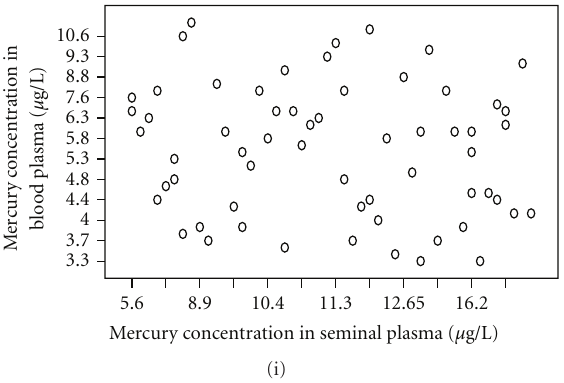
Figure 1: (a) Relation between lead concentrations in seminal plasma and blood plasma. (b) Relation between lead concentrations in seminal plasma and whole blood. (c) Relation between lead concentrations in blood plasma and whole blood. (d) Relation between cadmium concentrations in seminal plasma and blood plasma. (e) Relation between cadmium concentrations in seminal plasma and whole blood. (f) Relation between cadmium concentrations in blood plasma and whole blood. (g) Relation between mercury concentrations in blood plasma and whole blood. (h) Relation between mercury concentrations in seminal plasma and whole blood. (i) Relation between mercury concentrations in blood plasma and whole blood.